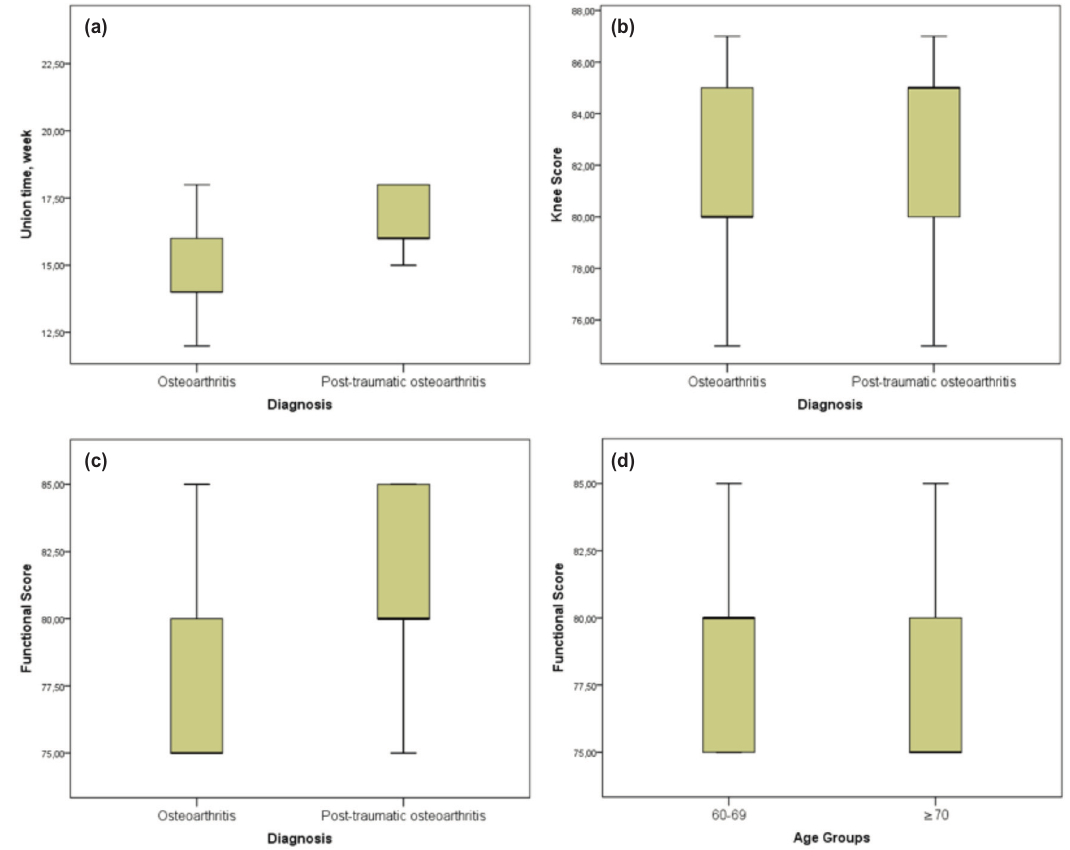
(a) Union time in diagnosis groups. (b) Knee score in diagnosis groups. (c) Functional scores in diagnosis groups. (d) Functional Fig. 3: scores in age